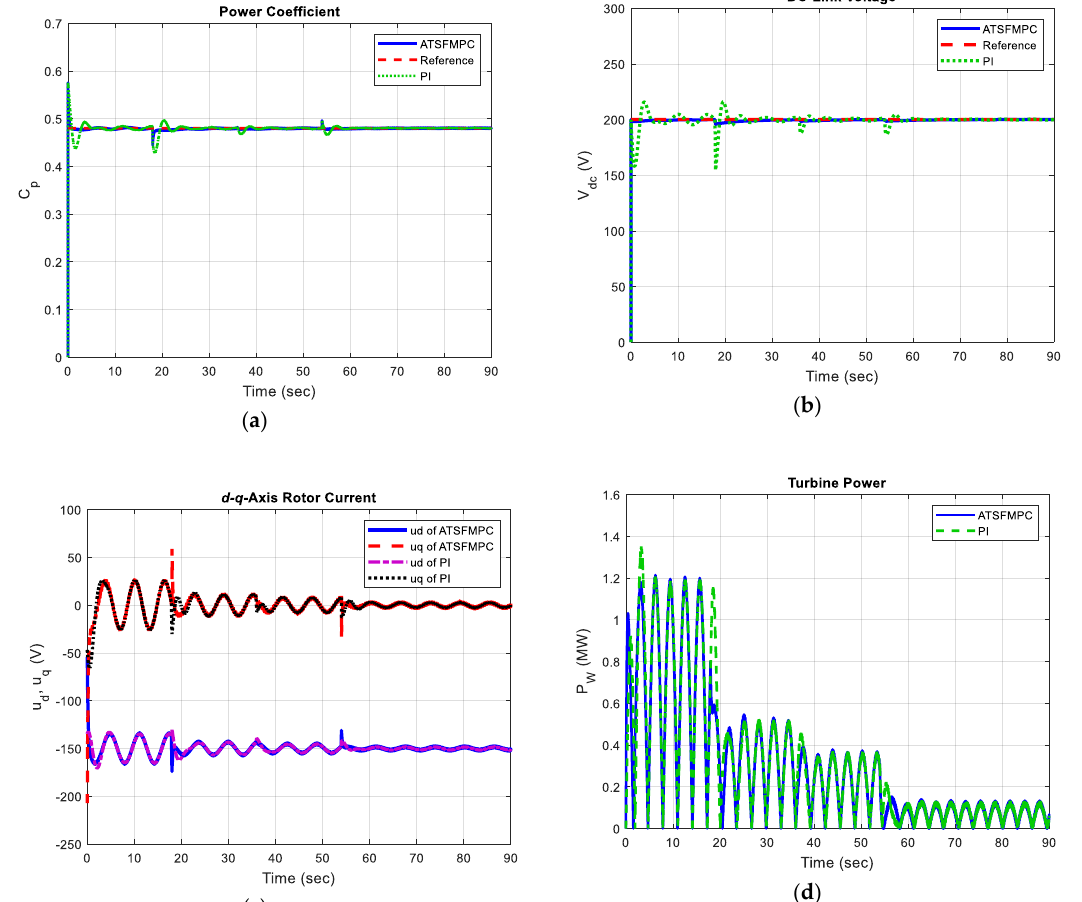
Figure 9. Response of d -axis and q -axis rotor currents for PI and ATSFMPC for Pentland Firth tidal current.